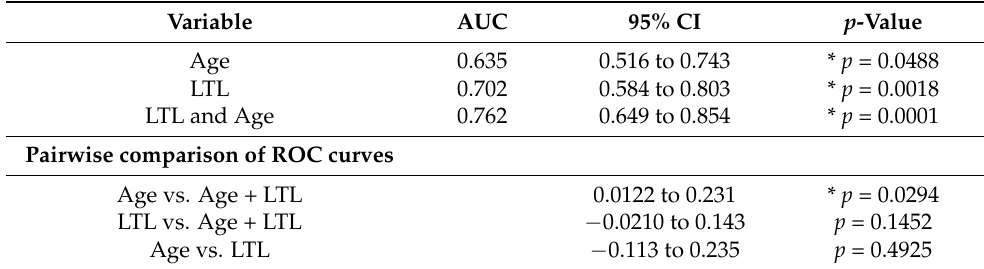
Table 3. Model comparison